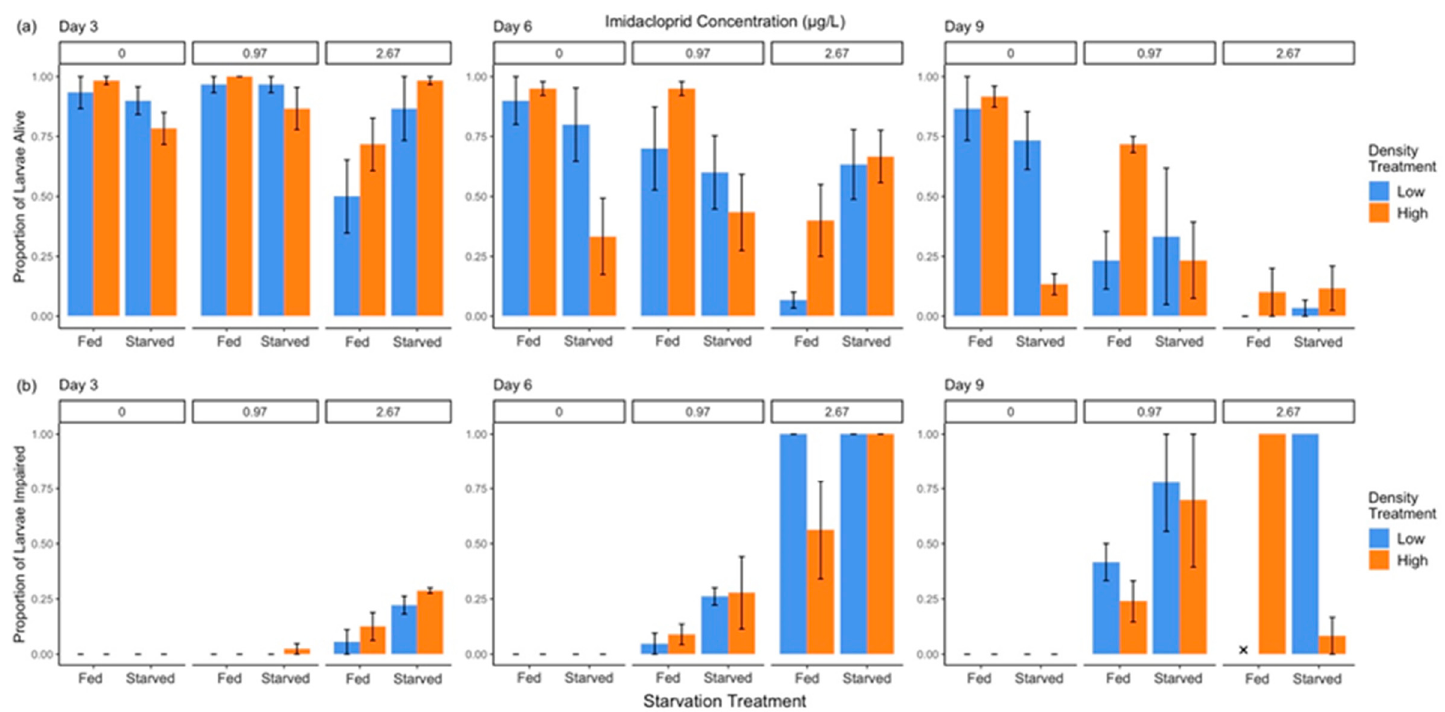
Figure 1. Responses of ( a ) survivorship and ( b ) impairment to the three imidacloprid treatments at the two mayfly nymph densities (10 and 20) and in the two starvation treatments (starved = starved for five days immediately prior to the imidacloprid exposure period). Bars represent means ± SEs. In cases where bars are missing, ‘×’ represents a treatment group in which all mayflies had died in all replicates—i.e., no sublethal responses were measured—whereas ‘_’ represents a zero value. See Tables 2 and 3 for statistical results.